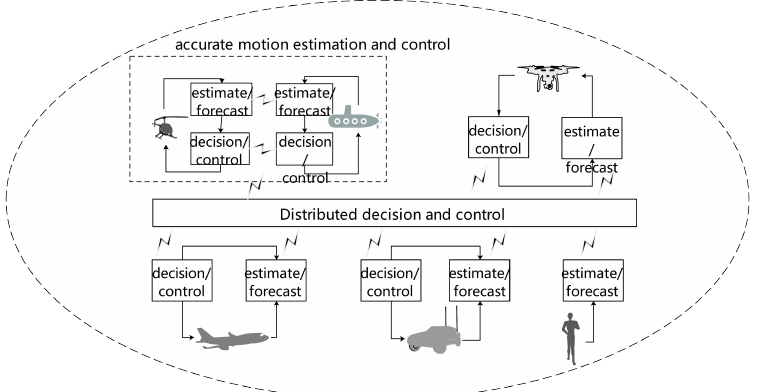
Figure 10. The Offensive Swarm-Enabled Tactics (OFFSET)